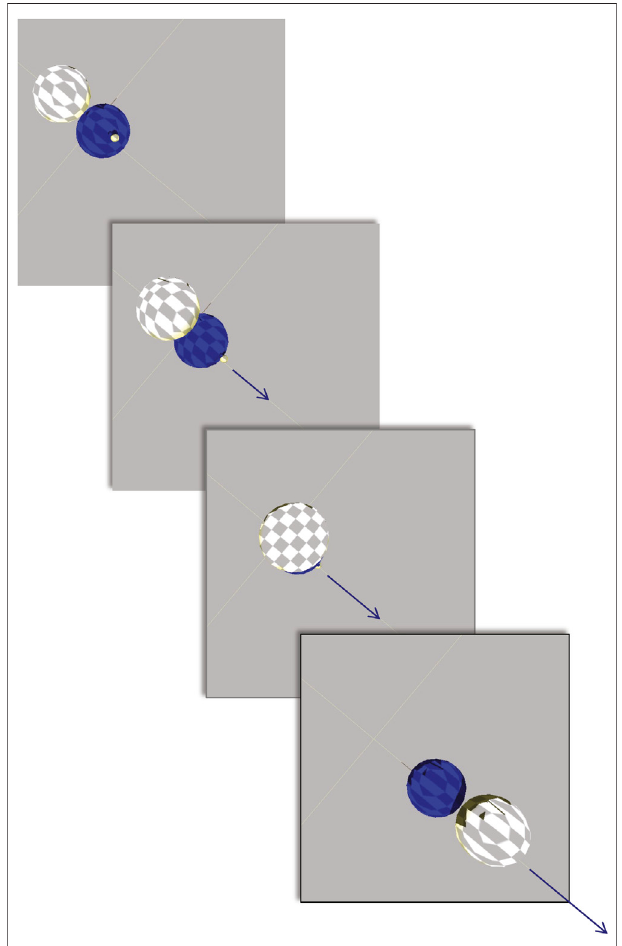
FIGURE5| Anembodied robotlocomoting.Viewfromoverhead.Robot from Figure 4D , with high fi tness, locomotes by continually fl ipping one sphere over the other. The arrow indicates both the magnitude and the orientation of the locomotor velocity. Video of robots locomoting is available in supplemental materials.